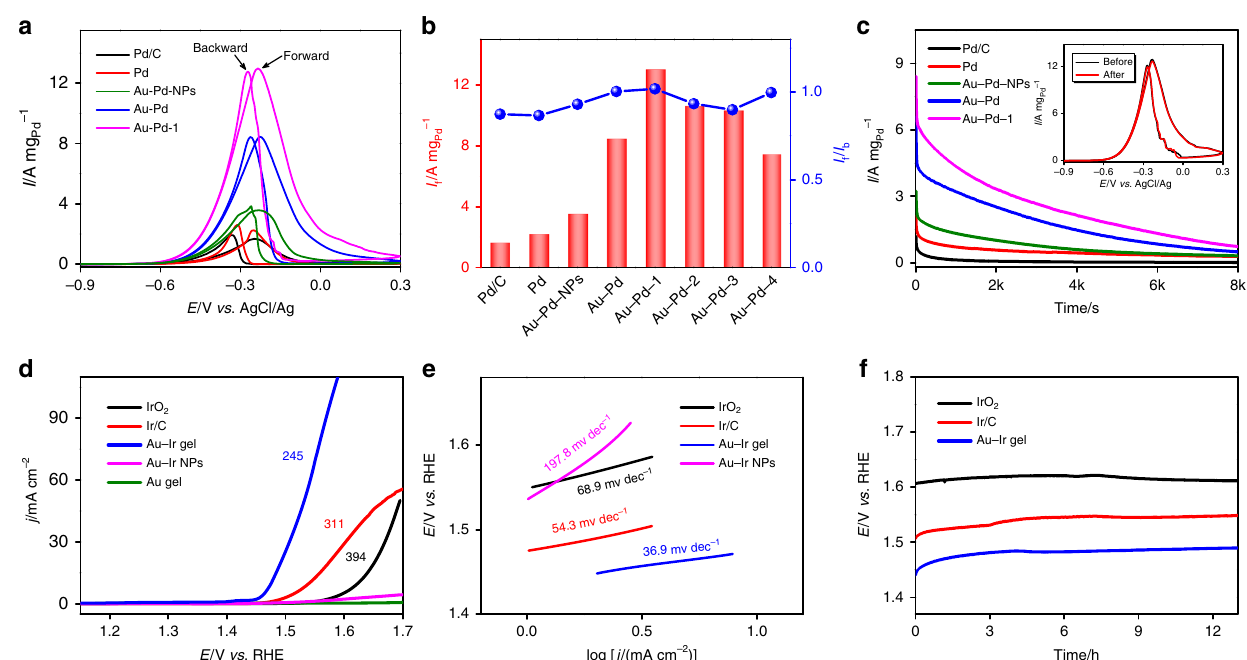
Fig. 4 Electrocatalytic performance of EOR and OER. EOR performance: a CV curves (scan rate 50 mV s − 1 ), b summarized I f and I f / I b , and c chronoamperometry tests of commercial Pd/C, Au-Pd NPs, and various aerogel catalysts in 1.0 M KOH + 1.0 M ethanol solution. The inset of c shows the CV curves of Au-Pd-1 before and after a 3 h chronoamperometry test. OER performance: d LSV curves (scan rate 5 mV s − 1 ), e Tafel plots, and f chronopotentiometric tests of commercial Ir/C, IrO 2 , Au aerogel, Au-Ir NPs, and Au-Ir aerogel in 1.0 M KOH aqueous